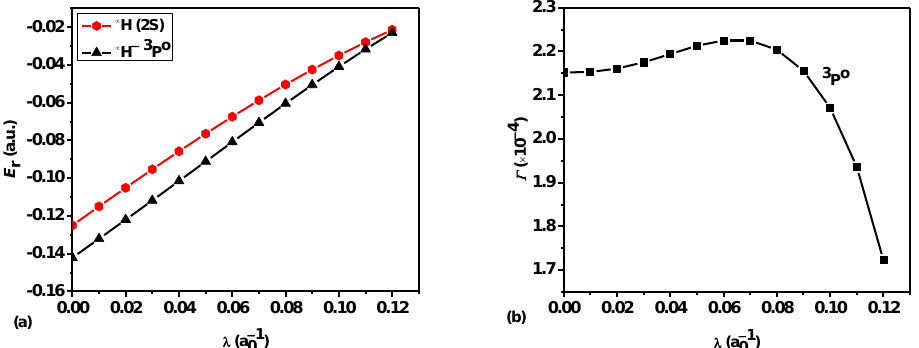
Figure 16. ( a ) Plot of the lowest 3 P o resonance energy 𝐸 𝑟 of ∞ H − as a function of the screening parameter 𝜆 . ( b ) Plot of the corresponding resonance width 𝛤 of ∞ H − as a function of the screening parameter 𝜆 .